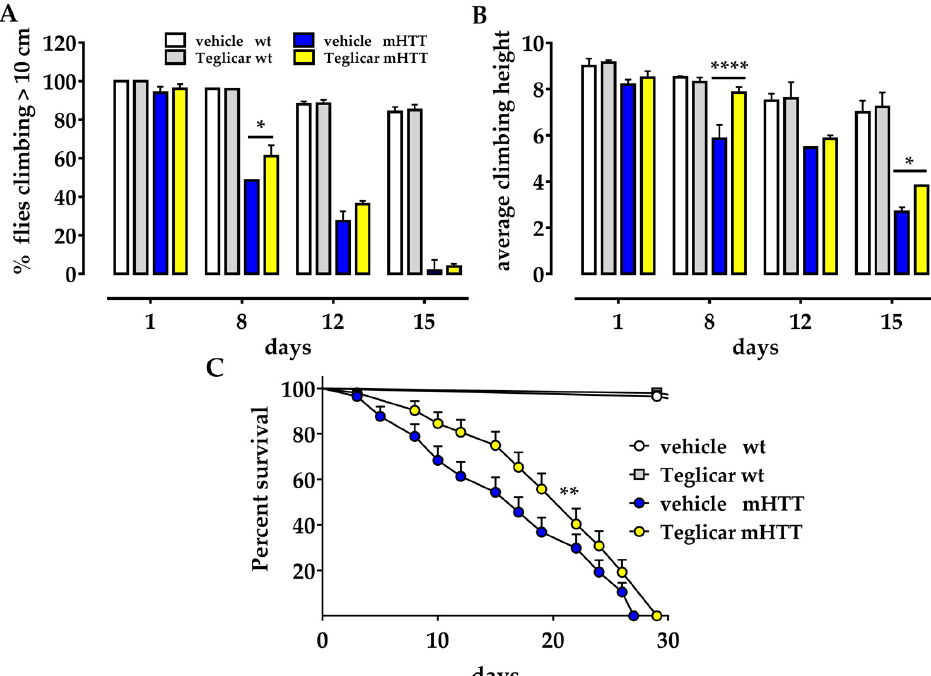
Figure 1. Teglicar suppresses the neurodegenerative phenotype in a Drosophila Huntington model. ( A ) Climbing assay. The percentage of Huntington’s flies (mHTT) that received chronic